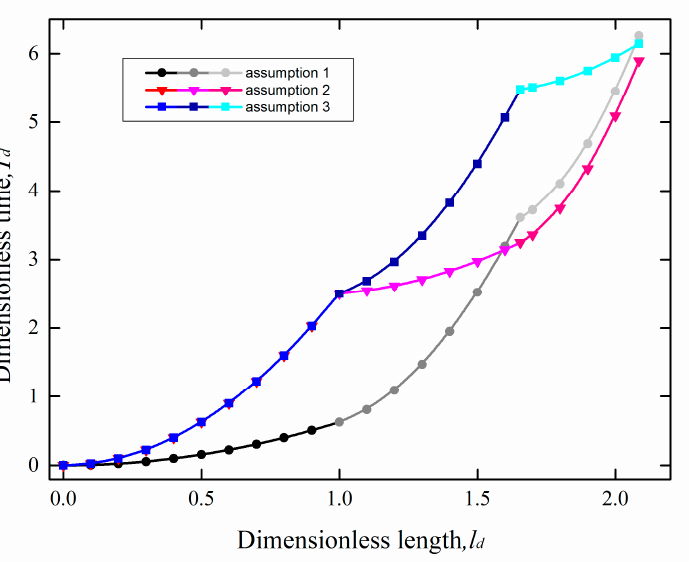
Figure 7. Dimensionless time varies with the distance of liquid flow in the first group of assumptions. The shortest imbibition time is obtained in realization 2. The fluid flows through the first-stage branch for a longer time in realization 2. However, the flow time of realization 2 is still shortest as the fluid flows faster and more time is shortened in the second-stage branch. In addition, the longest flow time occurs in realization 1. We compared the three branch in the three-level branch